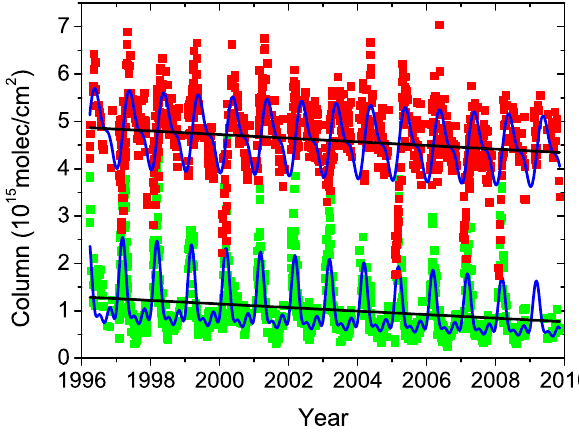
Fig. 3. Time series of HCl (red squares) and ClONO 2 (green squares) FTIR measurements in Kiruna from March 1996 until November 2009. The blue lines represent the least squares fit of Eq. (1) to each series, the black lines show the linear part of the fit result